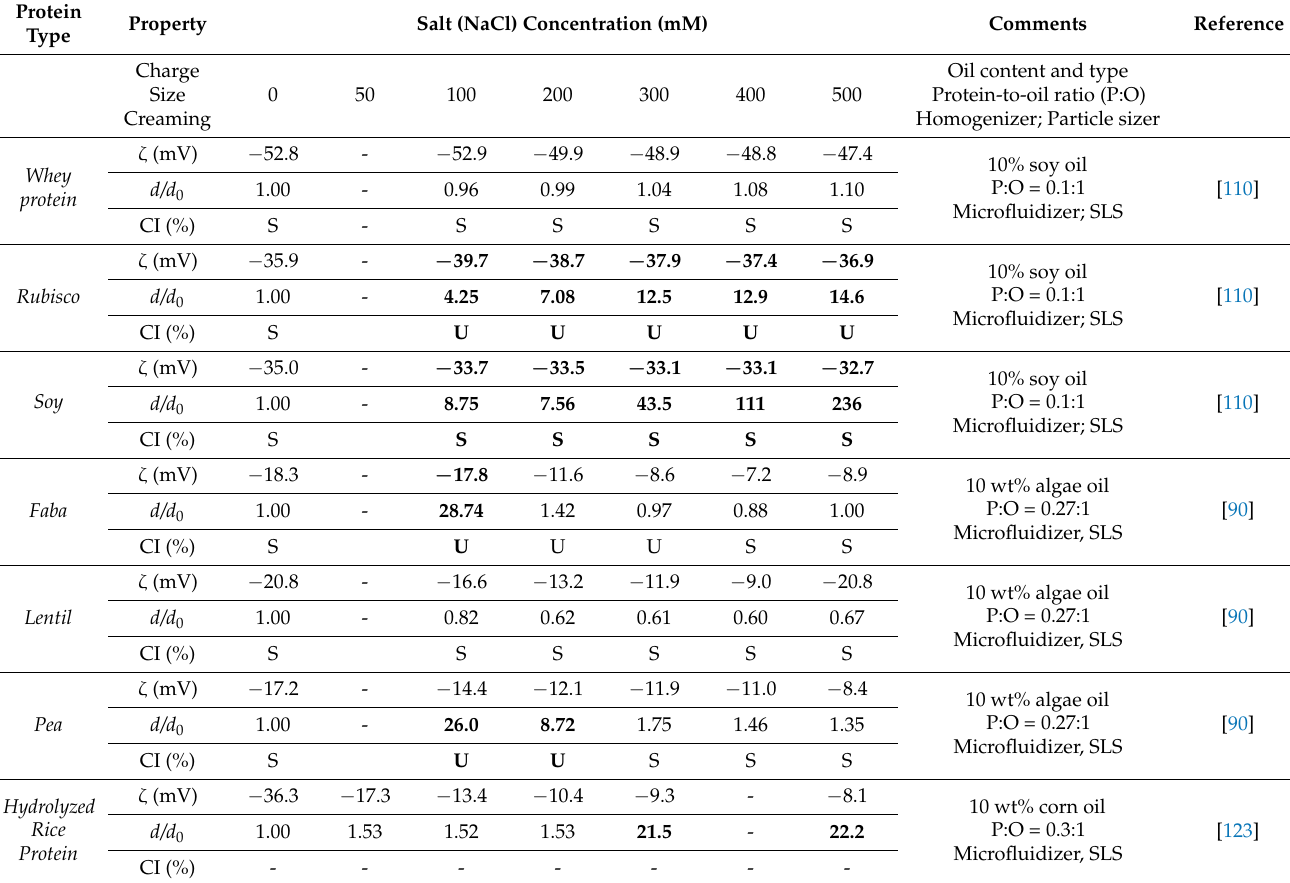
Table 3. Salt stability of protein-coated oil droplets in oil-in-water emulsions. Regions in bold show where extensive droplet aggregation occurs. Key : ζ = ζ -potential; d/d 0 is the particle diameter at specified salt concentration divided by particle diameter in the absence of salt; CI is the creaming index measured after storage for certain time at ambient